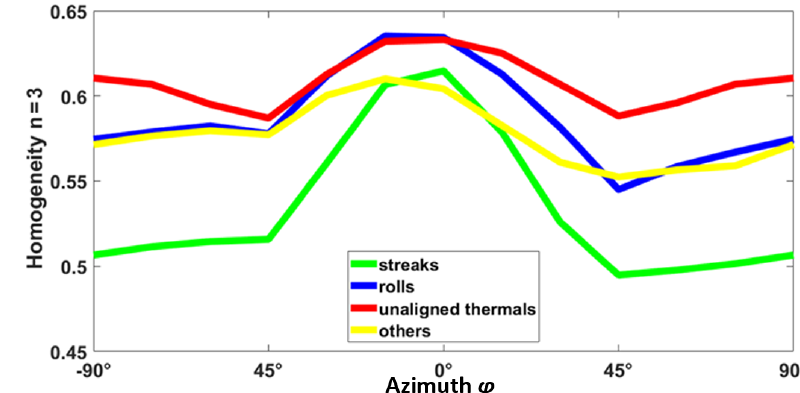
Figure 7. Third-neighbour homogeneity as a function of azimuth for one selected scan of each type.